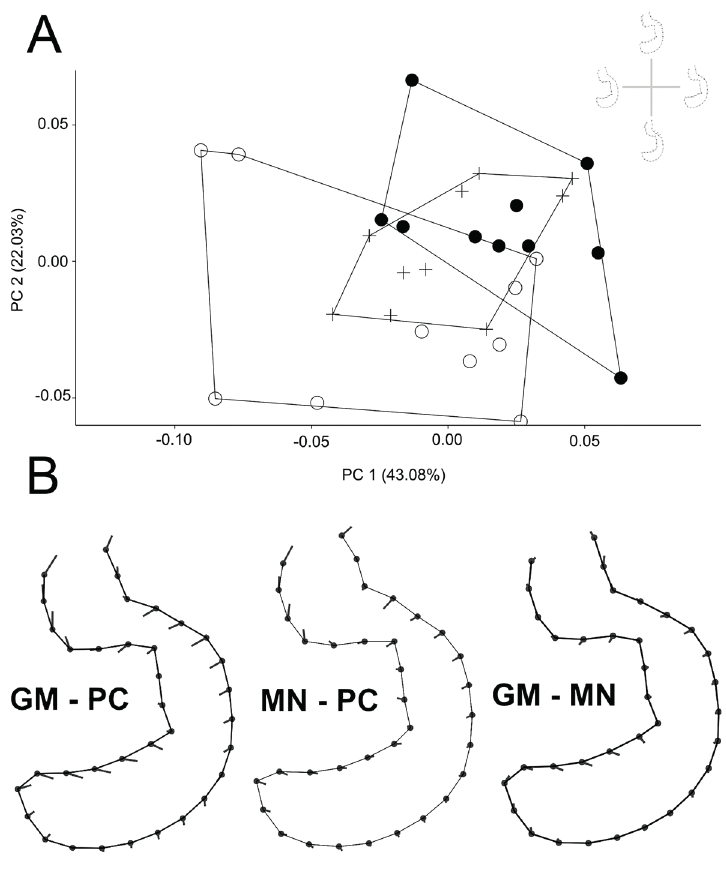
FIGURE 7 | A. Principal Component Analysis (PCA) of sulcus acusticus’s shape variation using Procrustes residual of geometric morphometric method. Shape variation in each principal component (PC1 in the horizontal and PC2 in the vertical) in the upper left corner. B. Pairwise shape comparisons; GM = Stellifer gomezi , MN = S. menezesi , PC = S. punctatissimus